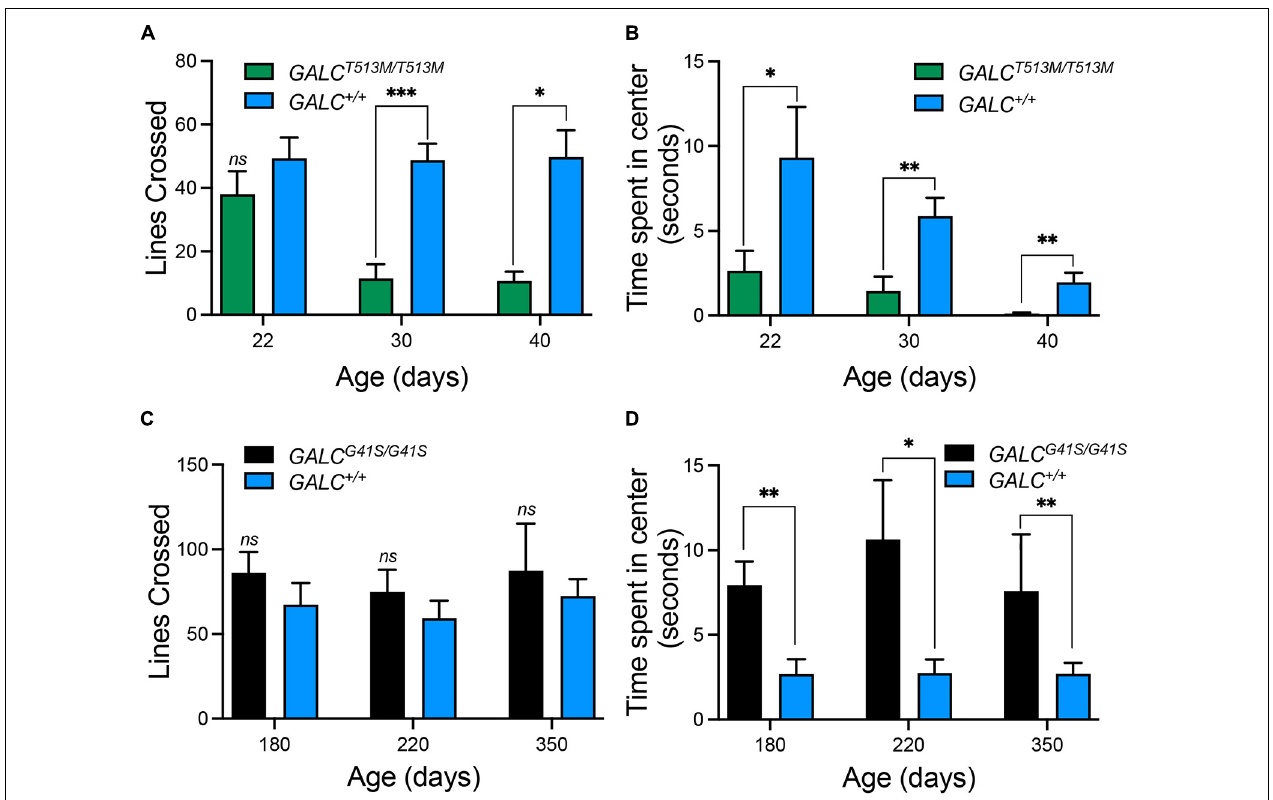
FIGURE 5 | Distinct exploratory behavior and anxiety-type responses exhibited by GALC T 513 M / T 513 M but not GALC G 41 S / G 41 S mice in the open field test. (A) Progressive loss of motor exploratory activity (measured as number of lines crossed) was observed in GALC T 513 M / T 513 M mice, starting at 30 days. (B) Signs of increased anxiety type responses (measured as time spent in the center quadrant) in GALC T 513 M / T 513 M mice were detected immediately after weaning. (C) GALC G 41 S / G 41 S mice exhibited normal motor activity at all time points. (D) GALC G 41 S / G 41 S mice showed signs of reduced anxiety-type behavior. Data represent the mean + SEM of n = 6–8/group, analyzed by ANOVA/Tukey’s post hoc test ∗ p < 0.05, ∗∗ p < 0.01, ∗∗∗ p <